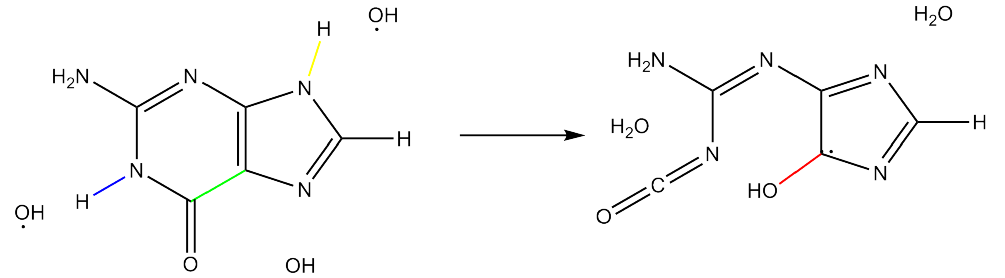
Figure 9. Reaction products of the electrolysis of guanine 3 . 3b – 3f : Reaction products at the anode. 3g was observed at the cathode, 3a near both electrodes.